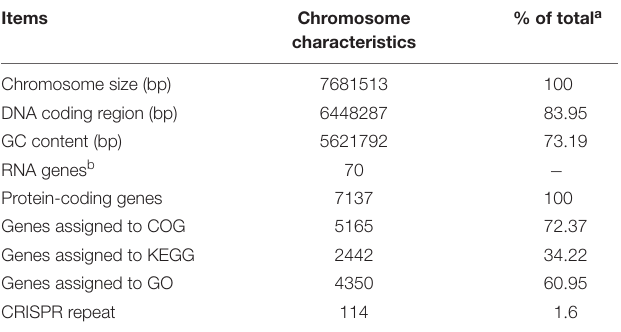
composition of fatty acids included Antesio-C 15 : 0